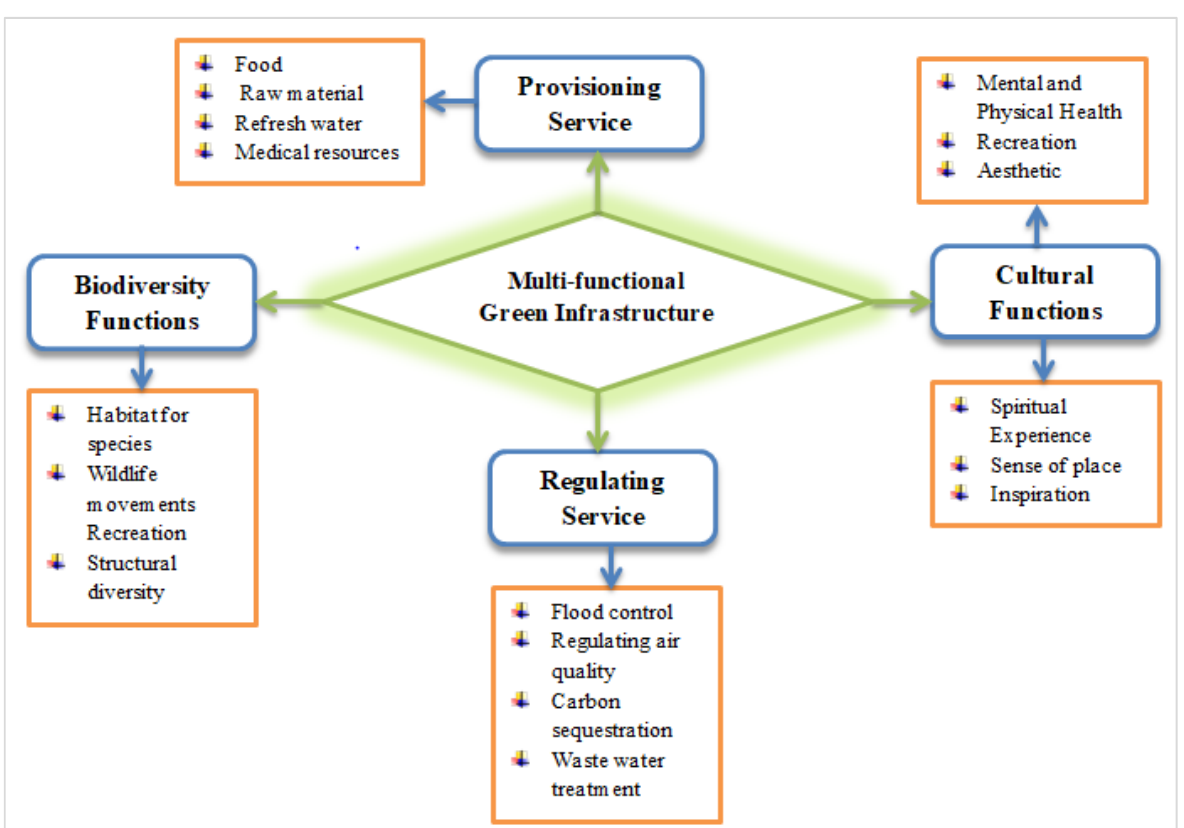
Figure 3. Different functions that should be considered in improving the quality standard.